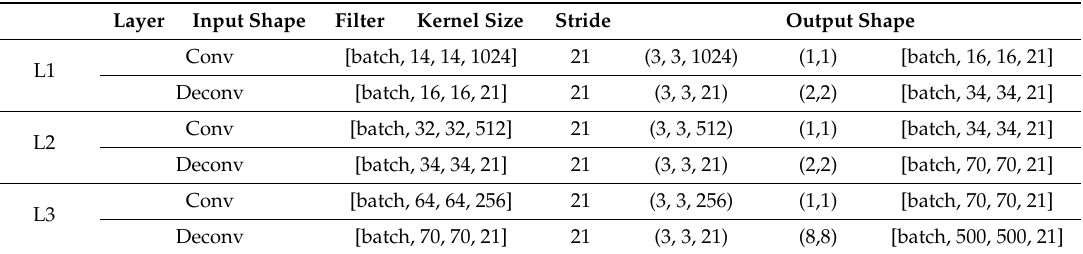
Figure 4. Material organization structure segmentation model (SegModel-MOS) architecture. Table 2. SegModel-MOS parameters.